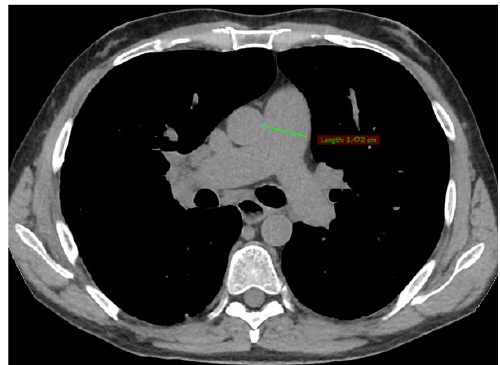
Figure 2. Dilated pulmonary artery trunk at repeated HRCT.